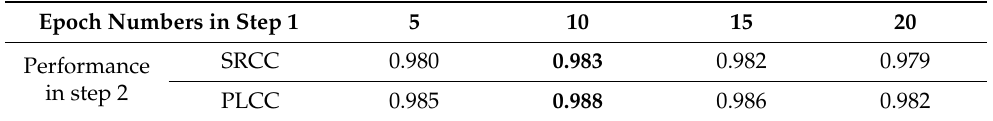
Table 2. Comparison of the performance of step 2 with different training epochs in step 1.